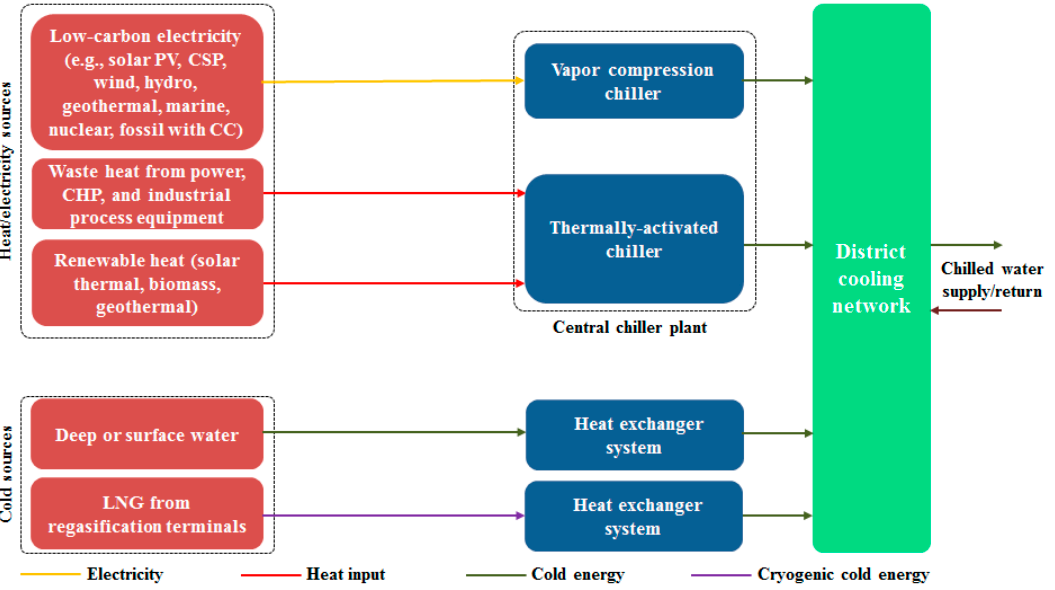
Figure 2. Sustainable cold production options for DC systems.